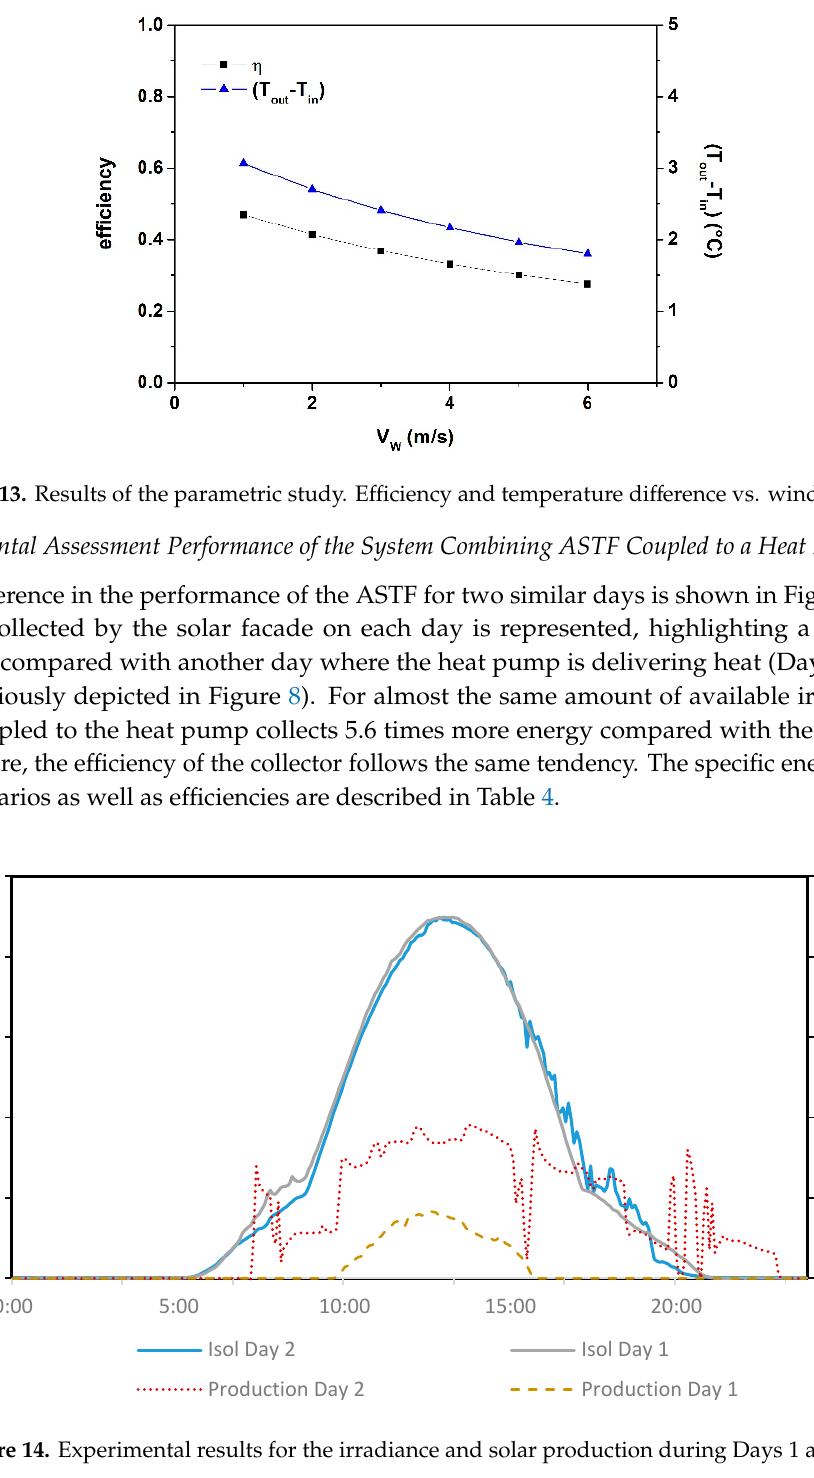
Figure 12. Results of the parametric study. Efficiency and temperature difference vs. solar irradiation.